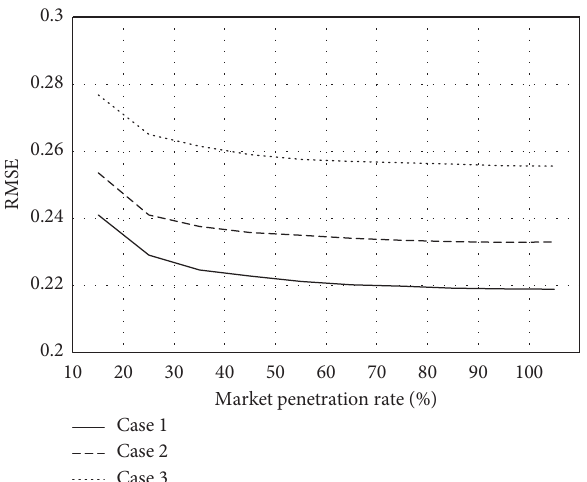
Figure 7: Effect of sampling rate on the RMSE for three cases of SCWS application.